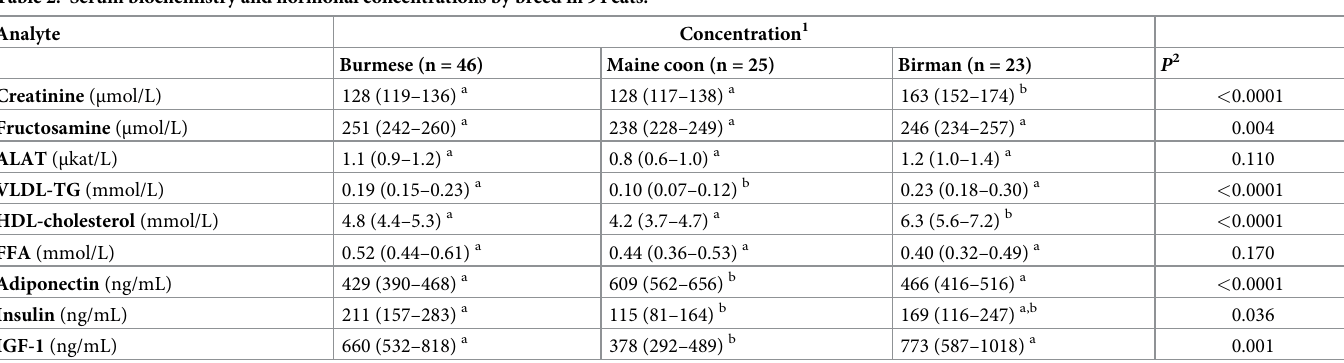
Table 2. Serum biochemistry and hormonal concentrations by breed in 94